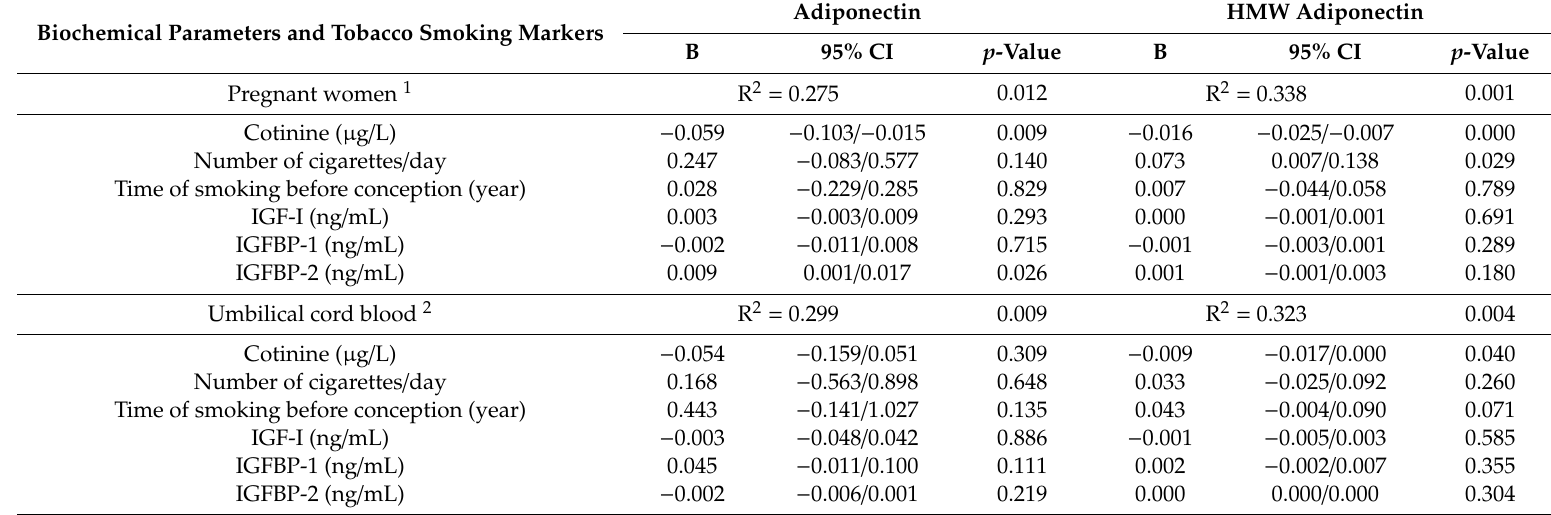
Table 3. Multivariate regression models for total adiponectin and its HMW isoform in pregnant women and umbilical cord blood. Biochemical Parameters and Tobacco Smoking